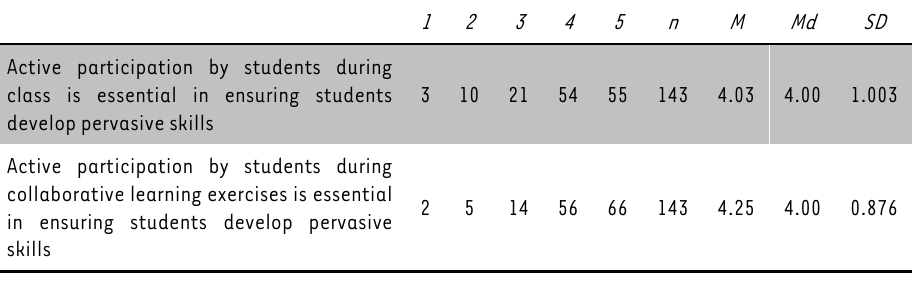
2 5 14 56 66 143 4.25 4.00